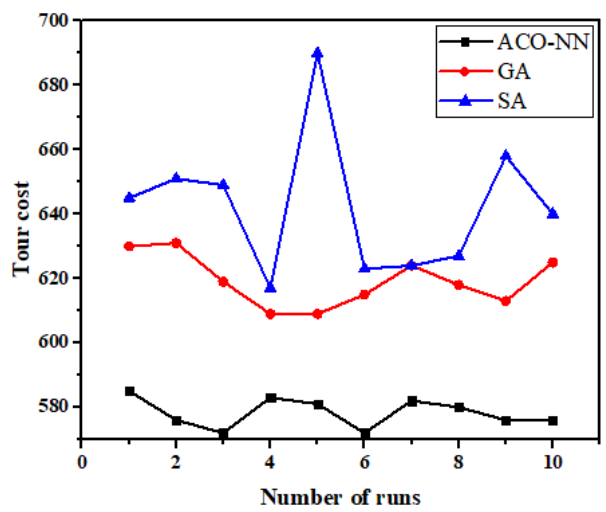
Figure 3. Comparison of ACO-NN to GA and SA for Eil76.